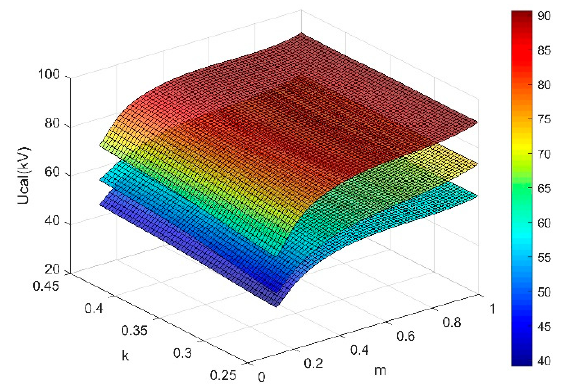
Figure 15. The e ff ects of m and k on U cal under di ff erent SDD. Figure 15. The effects of m and k on U cal under different SDD. Table 3. Fitting